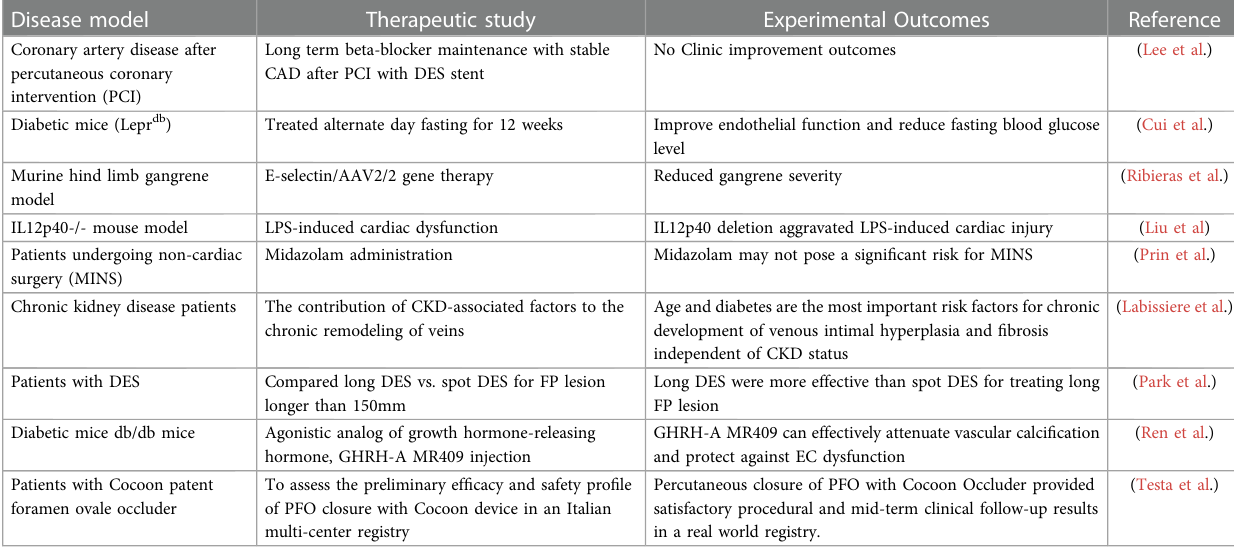
TABLE 1 Nine highly viewed research papers, published in our special topic entitled “ Insights in Cardiovascular Therapeutics: 2022 ” , are summarized. Disease model Therapeutic study Coronary artery disease after percutaneous coronary intervention (PCI)